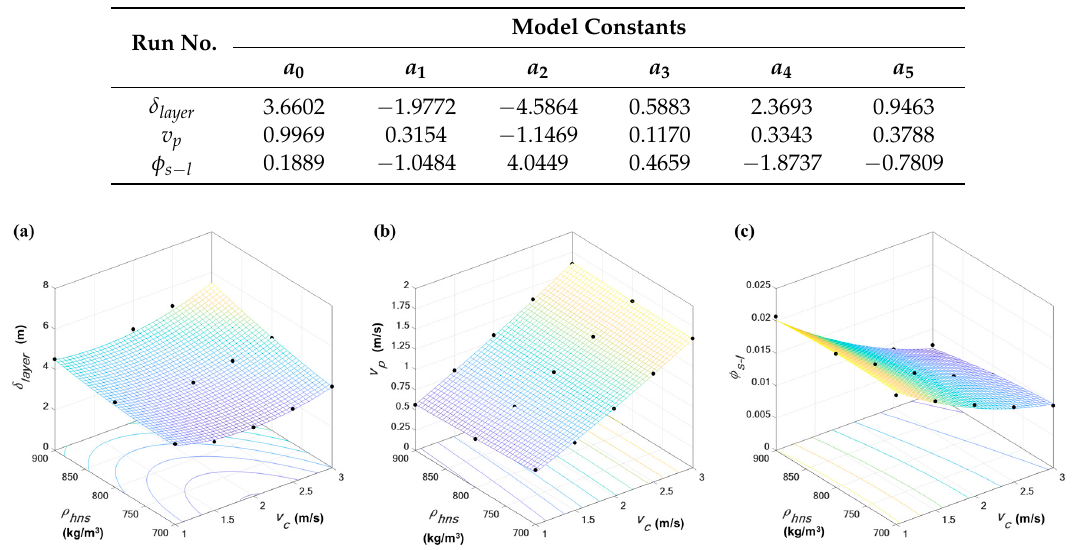
Table 1. Model constant of second-order response surface model (RSM).